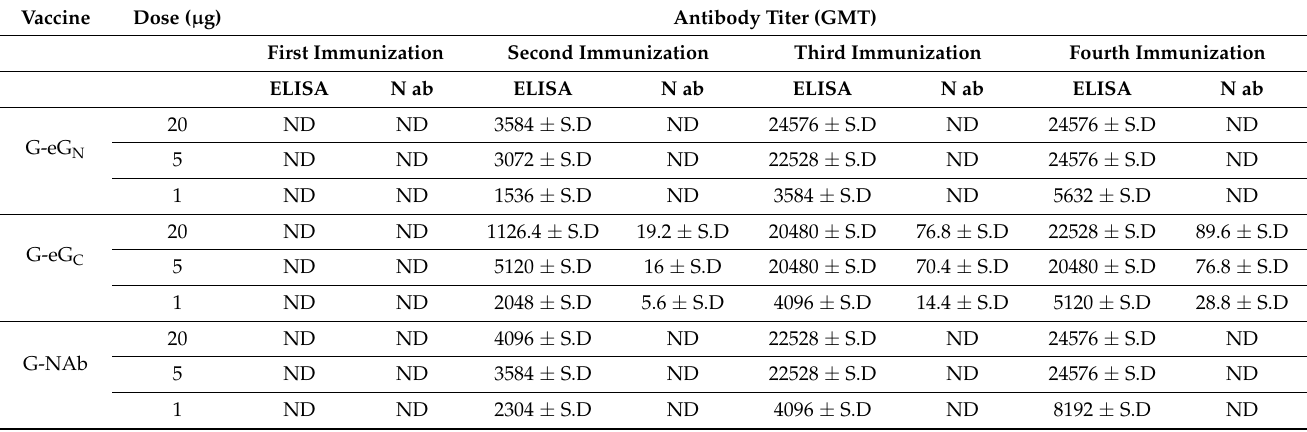
Table 3. Comparison of the serological responses in BALB/c mice subcutaneously immunized with G-GP vaccines against CCHFV. Booster doses were given at 3, 6 and 9 weeks after the first immunization, and virus-specific antibodies in mice were assessed at 2, 5, 8, 11 weeks after the first immunization. The results were recorded as the geometric mean titer (GMT) ± the standard error